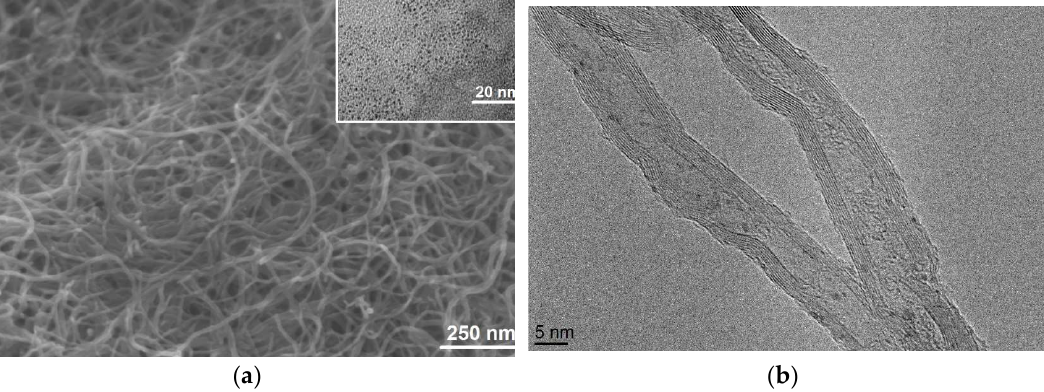
Figure 2. ( a ) SEM image showing the morphology of the IrO x -MWCNT sample. IrO x nanoparticles (bright spots) can be observed at the MWCNT surface. The inset shows a TEM image of as synthesized iridium oxide nanoparticles (dark spots). ( b ) HR-TEM image showing MWCNT with IrO x nanoparticles (dark spots).